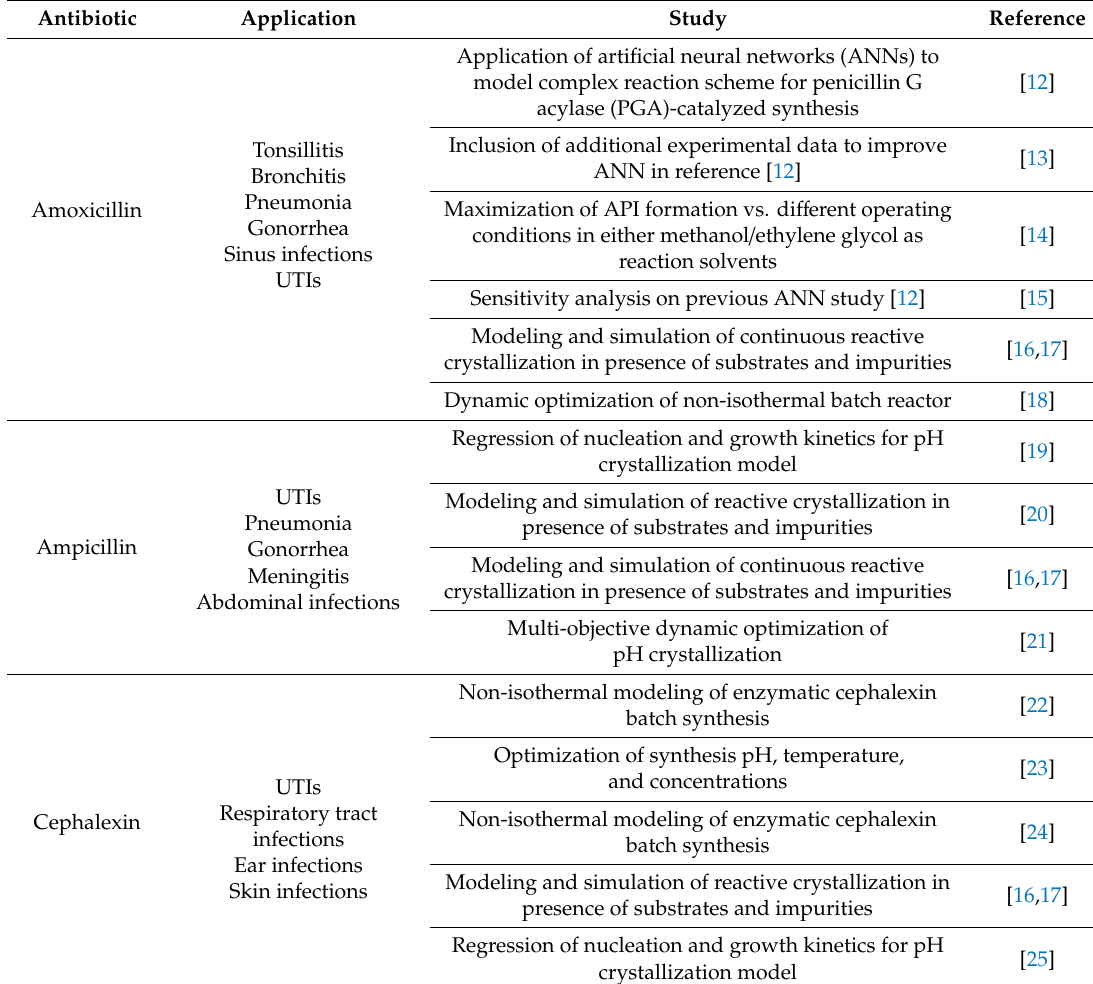
Table 1. Select modeling and optimization studies for human β -lactam antibiotic